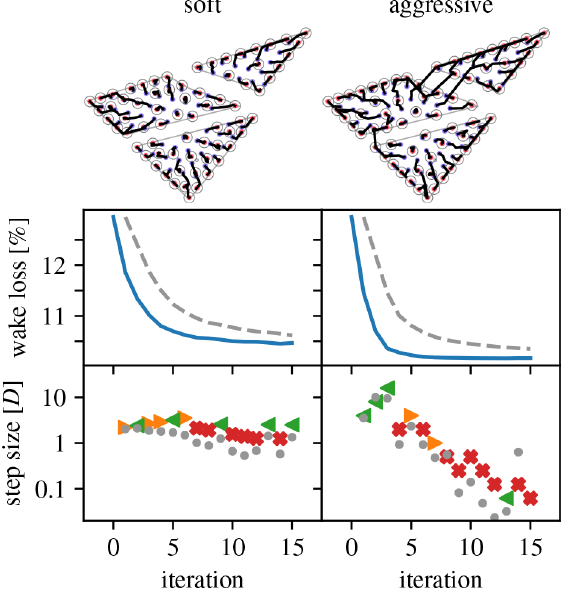
Figure 21. Overview of optimization runs for the Borssele IV wind farm layout problem, 70-turbine case. (Legend in Table 1.)